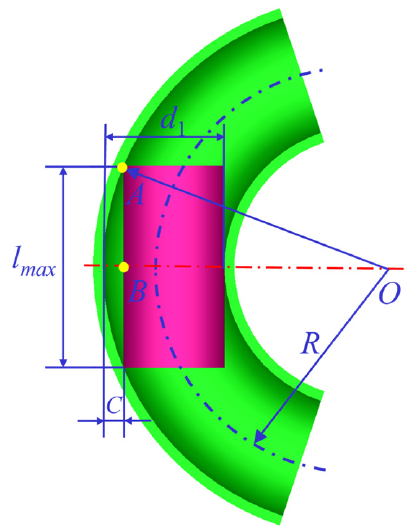
Figure 3. The geometric dimensions of the flexible joint.